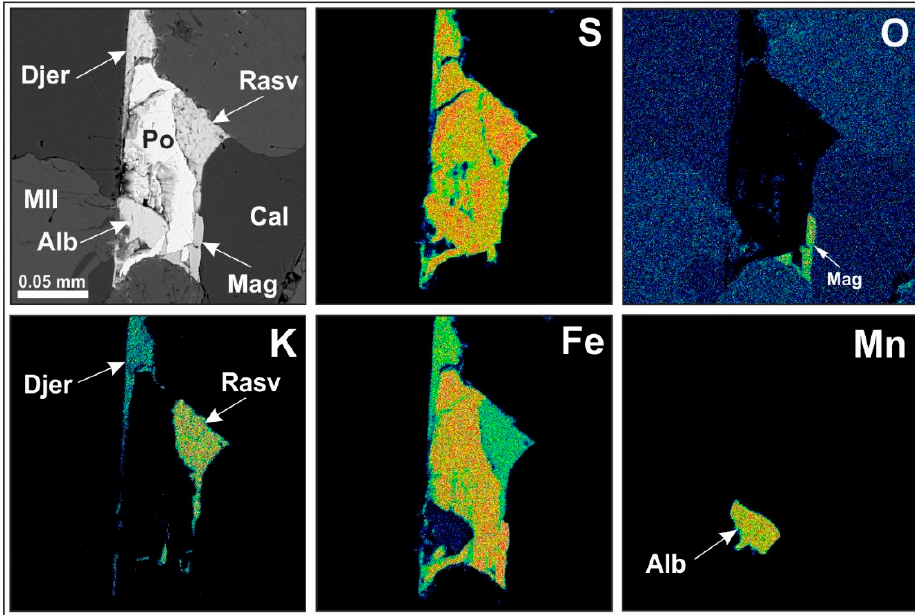
Figure 13. BSE image and X-ray elemental maps (S, O, K, Fe, Mn) showing partly replacement of pyrrhotite by later K-sulfides (rasvumite and djerfisherite) and remained intact alabandite inclusion (Kochumdek marble, Zone 4, sample PT-88). Alb = alabandite, Cal = calcite, Djer = djerfisherite, Mag = magnetite, Mll = melilite, Po = pyrrhotite, Rasv = rasvumite.